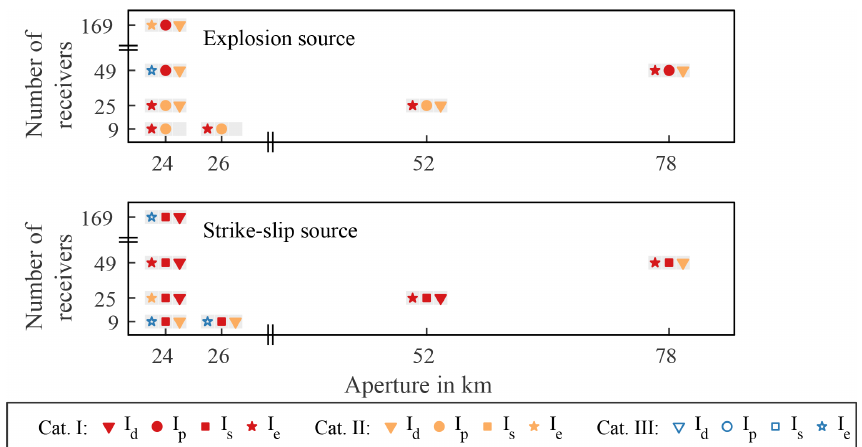
Figure 5. The location accuracy achieved with an increased number of stations. Two source types were tested at a depth of 11.9km. Receivers were either added between the nine existing stations (aperture stays the same) or outside of the nine existing receivers (aperture increases). The locations achieved with the individual imaging conditions were ranked according to the categories from Fig. 2. Grey bars indicate set-ups that were tested. No symbol in the grey bar means that the location was unsuccessful. Symbol types and colours in the grey bars represent successful locations with the imaging condition sorted into the respective